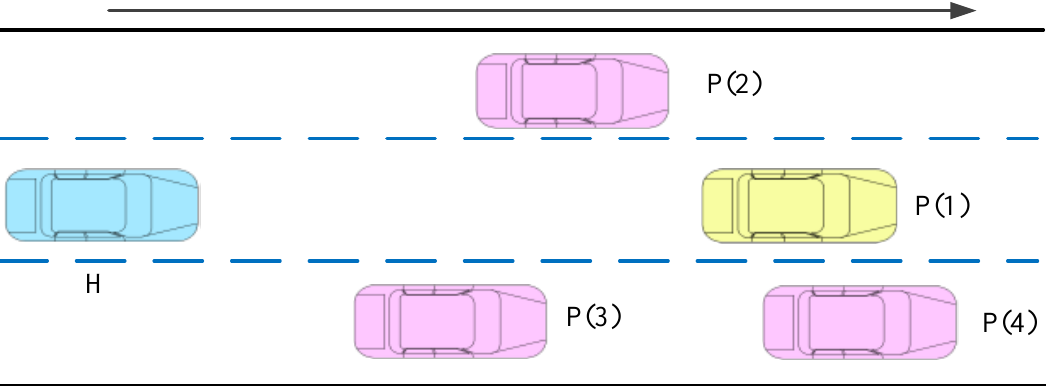
Figure 6. Vehicle ’s body overlap.